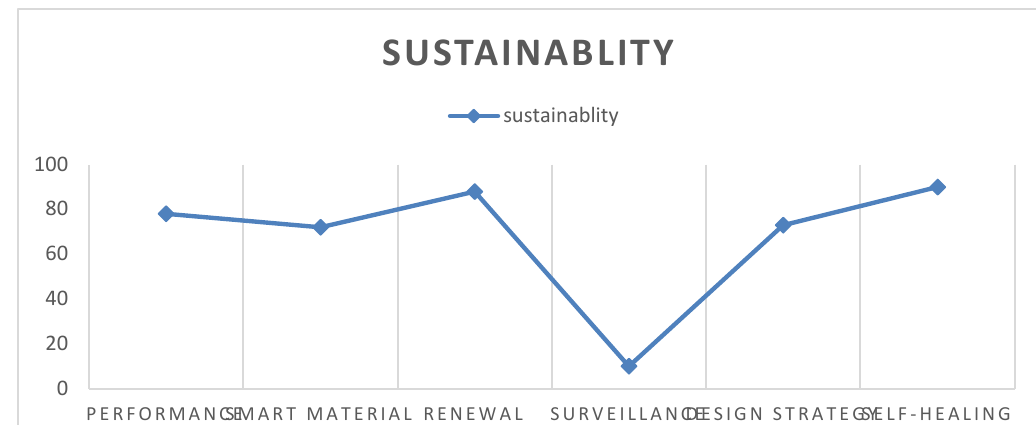
Fig. 10. Different type of architectures being evaluated for sustainability and self-healing mechanism in terms of surveillance and scrutiny factors (by researchers).